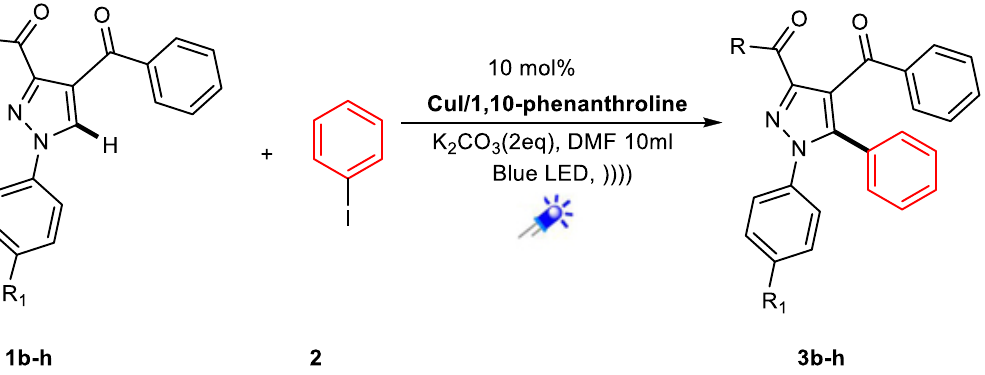
Figure 2. Structure of pyrazole synthesized via C-H arylation utilizing the designed sonophotore- actor.